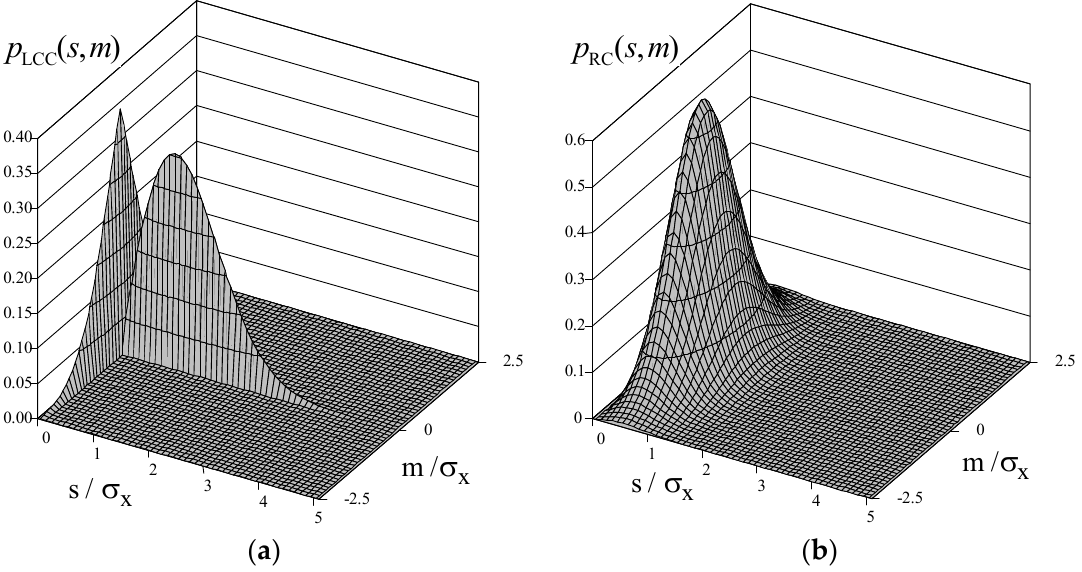
Figure 4. Amplitude–mean probability distributions in TB method: ( a ) level crossing counting; ( b ) approximate range counting. Representation of p LCC ( s , m ) is only qualitative, as it includes a Dirac delta function for s = 0 and m = 0. Reproduced from [32] with permission from